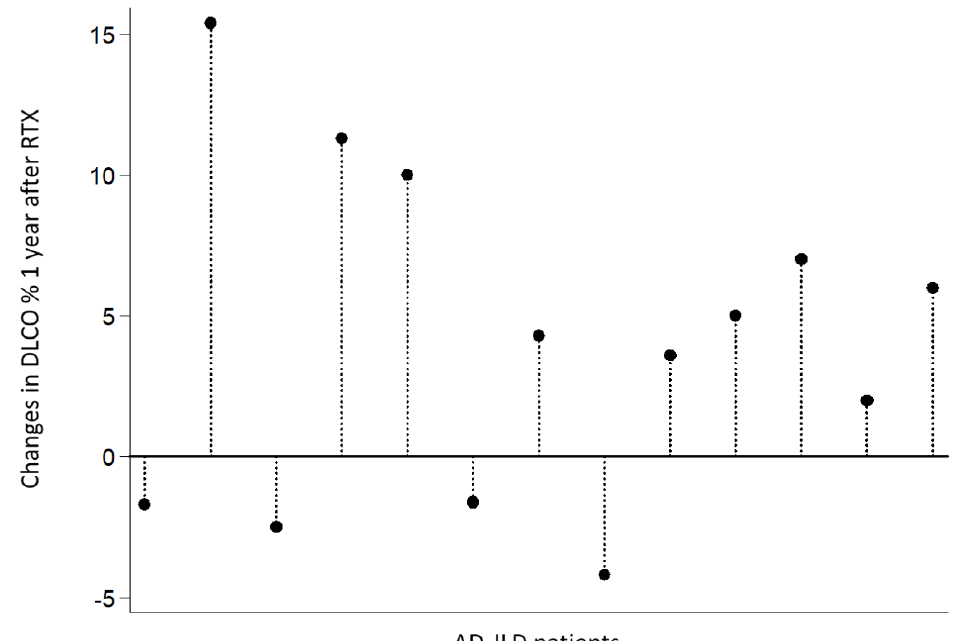
Figure 1. Changes in DLCO values in 13 AD-ILD patients 1 year after RTX. AD-ILD patients are ordered as follows: SSc-ILD (n = 4), IIM-ILD (n = 3), RA-ILD (n = 3), IPAF (n = 2) and MPO-ANCA-